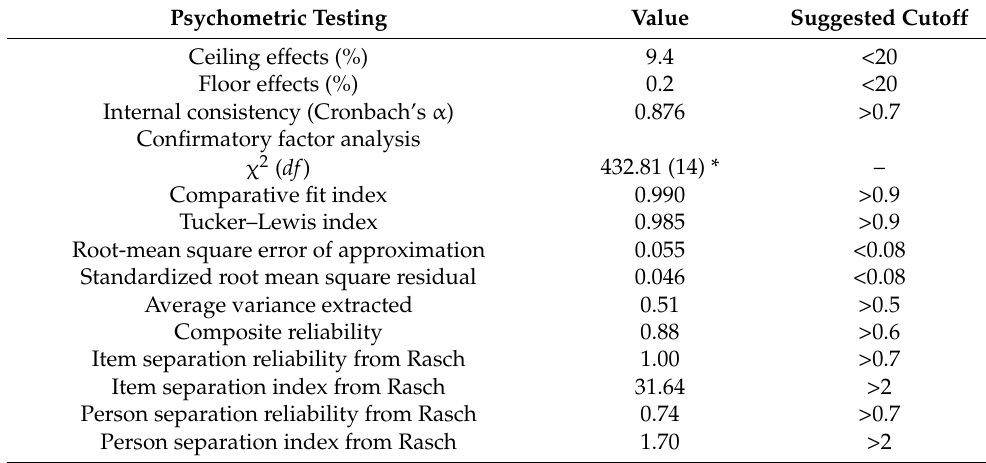
Table 5. Psychometric properties of the Insomnia Severity Index (ISI) in scale